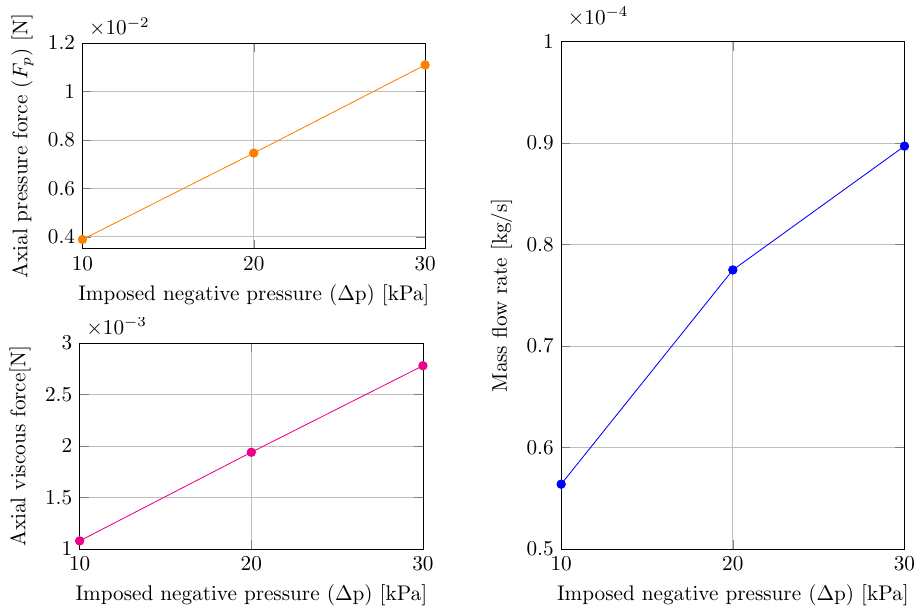
Figure 15. Dependence on imposed negative pressure: axial pressure force ( top left ), viscous force ( bottom left ) and mass flow rate ( right